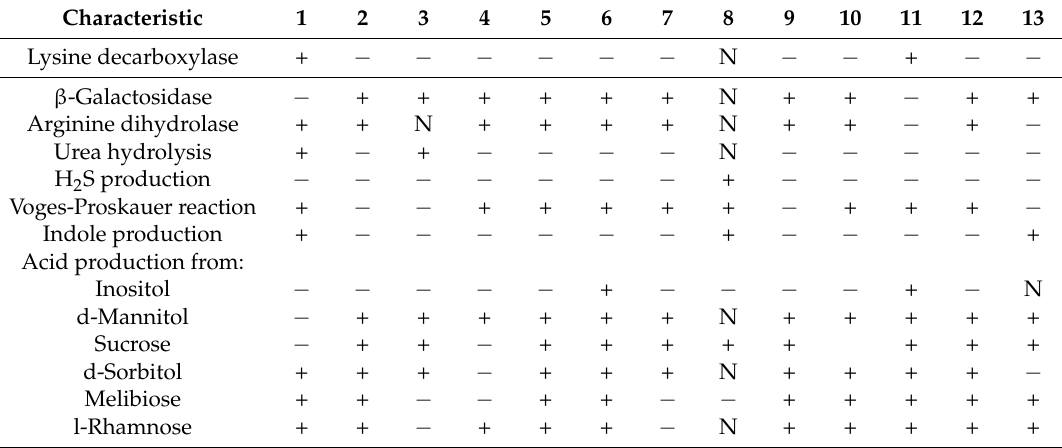
Table 3. Key characteristics distinguishing strain LX3 from other Enterobacter species. Species: